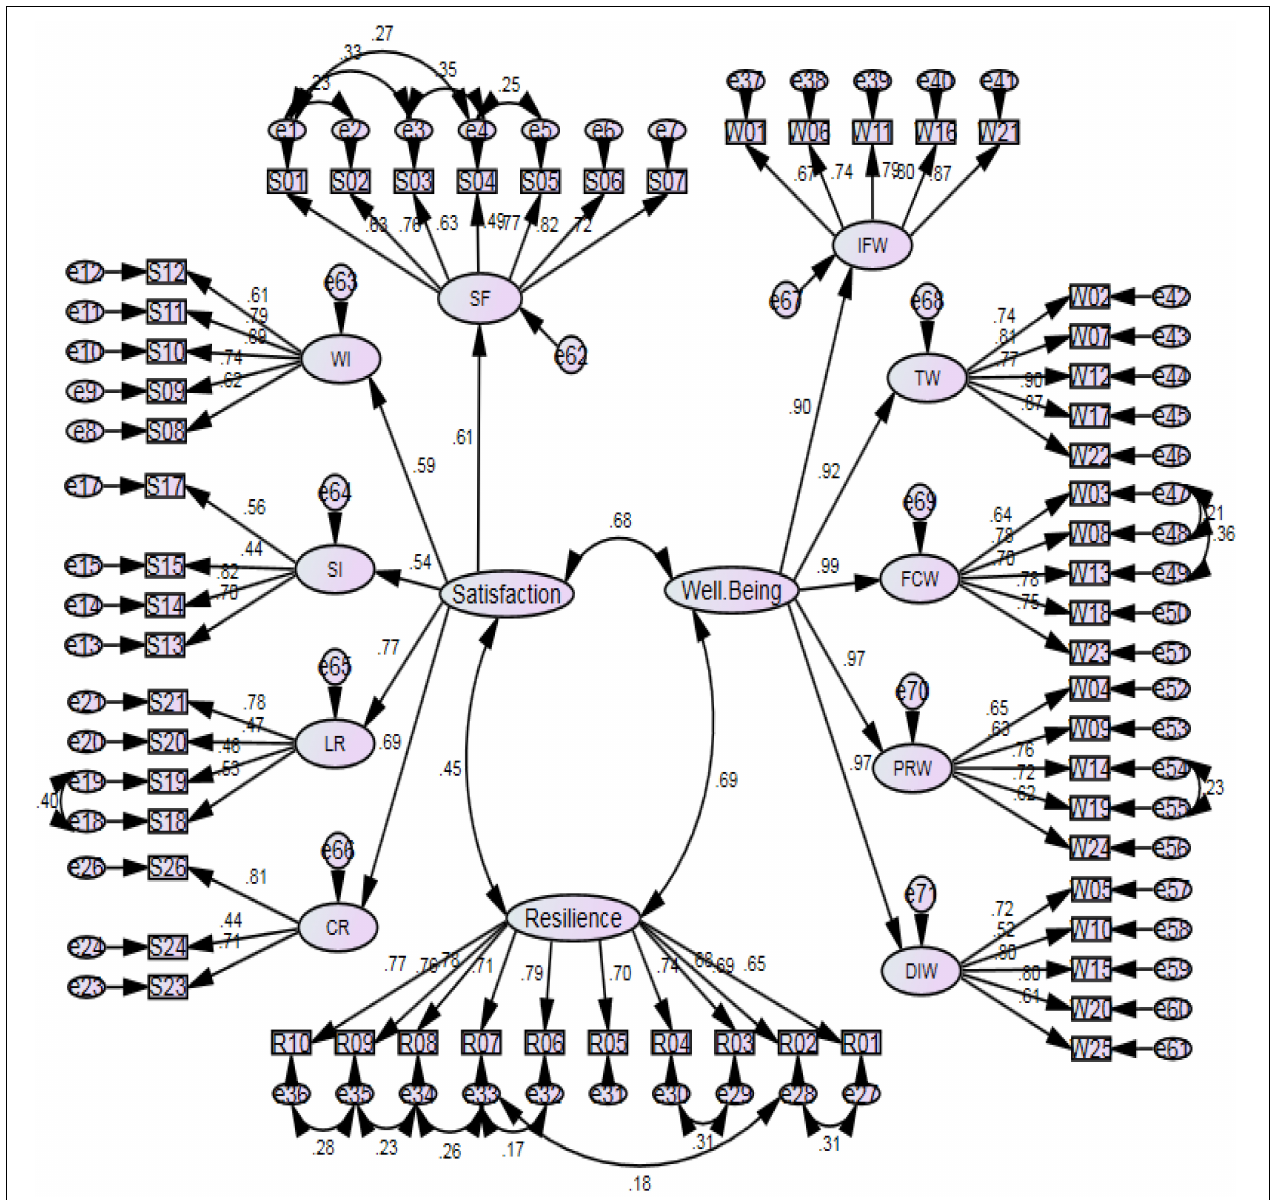
FIGURE 1 | The final modified CFA model with standardized